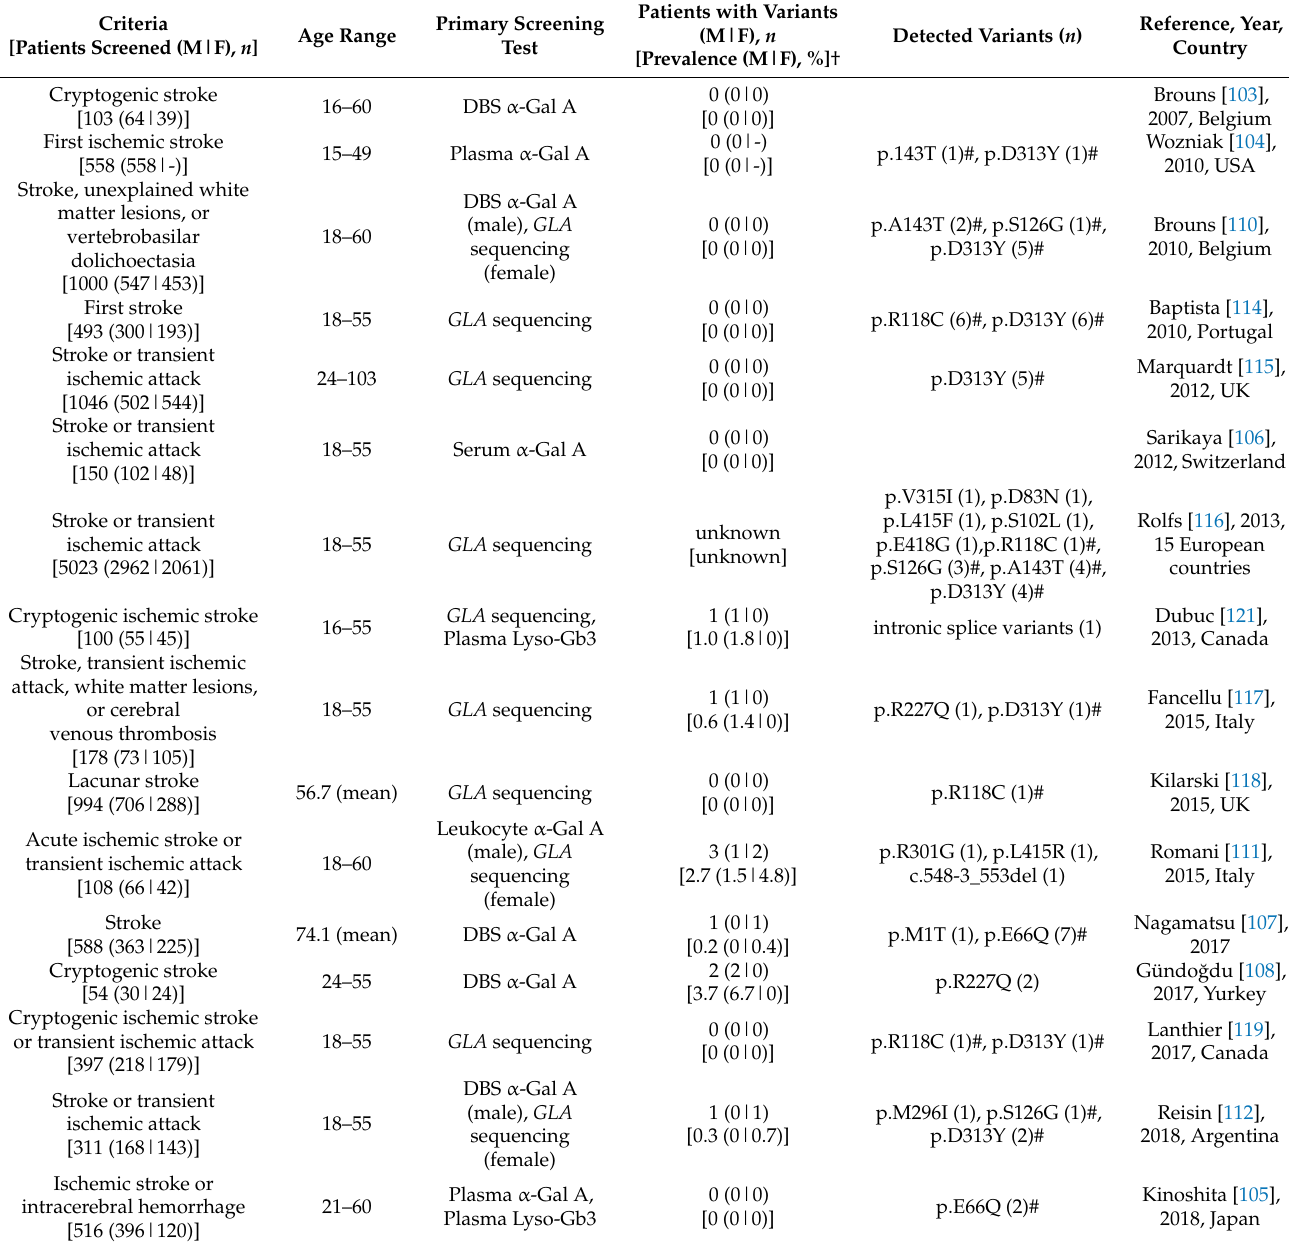
Table 3. Previous high-risk screening for FD in individuals with central neurological